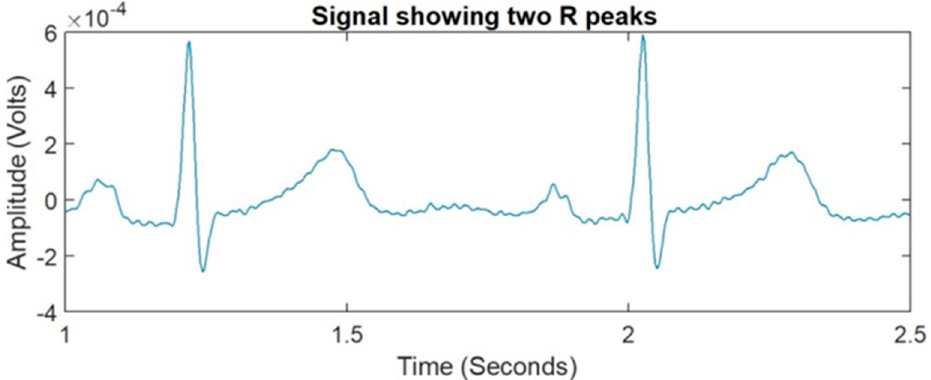
Figure 3. Filtered ECG and wave showing R peaks.